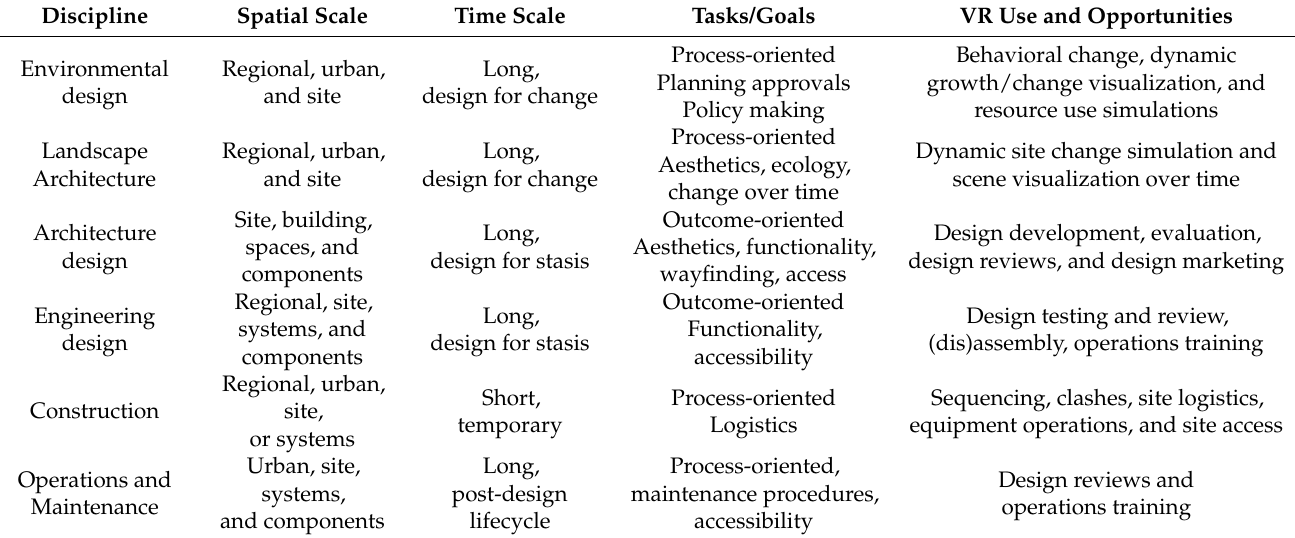
Table 1. Built environment disciplines from the perspectives of primary tasks, time and spatial scales, and VR use opportunities. Discipline Spatial Scale Time Scale Tasks/Goals VR Use and